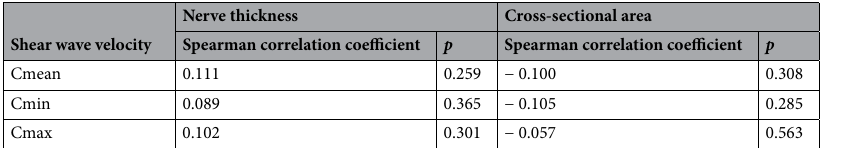
Table 6. Correlations between shear wave velocities and nerve thickness and cross-sectional